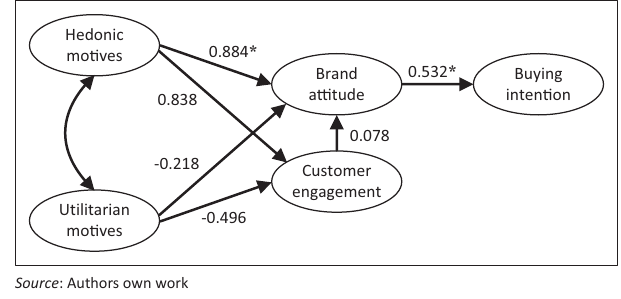
FIGURE 3: Structural model with standardised path